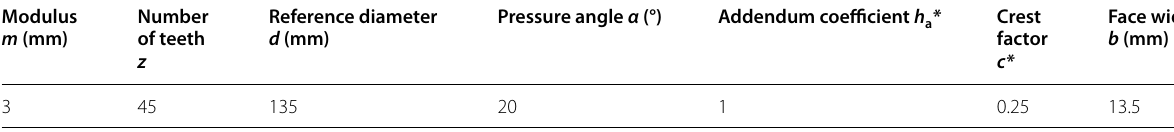
Table 1 The basic parameters of the formed gear in FEM model Modulus m (mm)